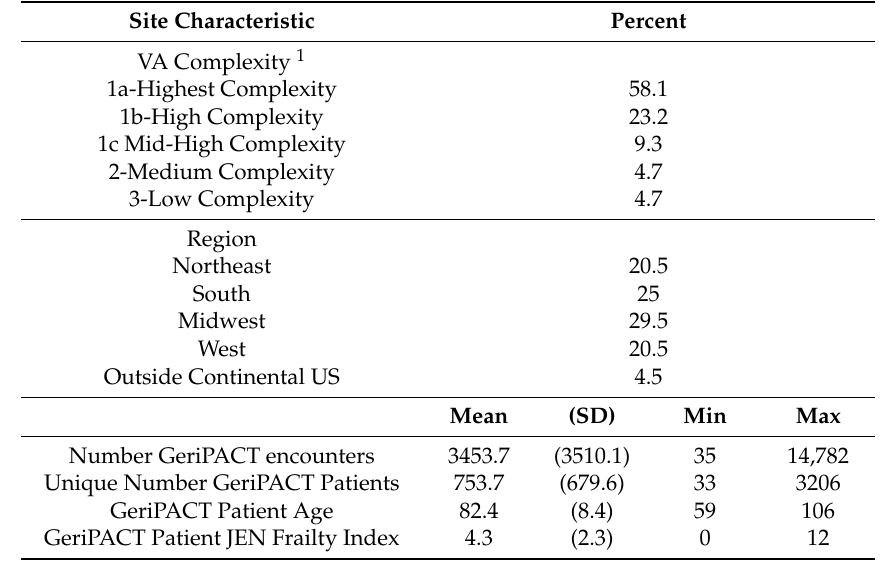
Table 1. Site and Patient Characteristics in FY2016 (N = 44).